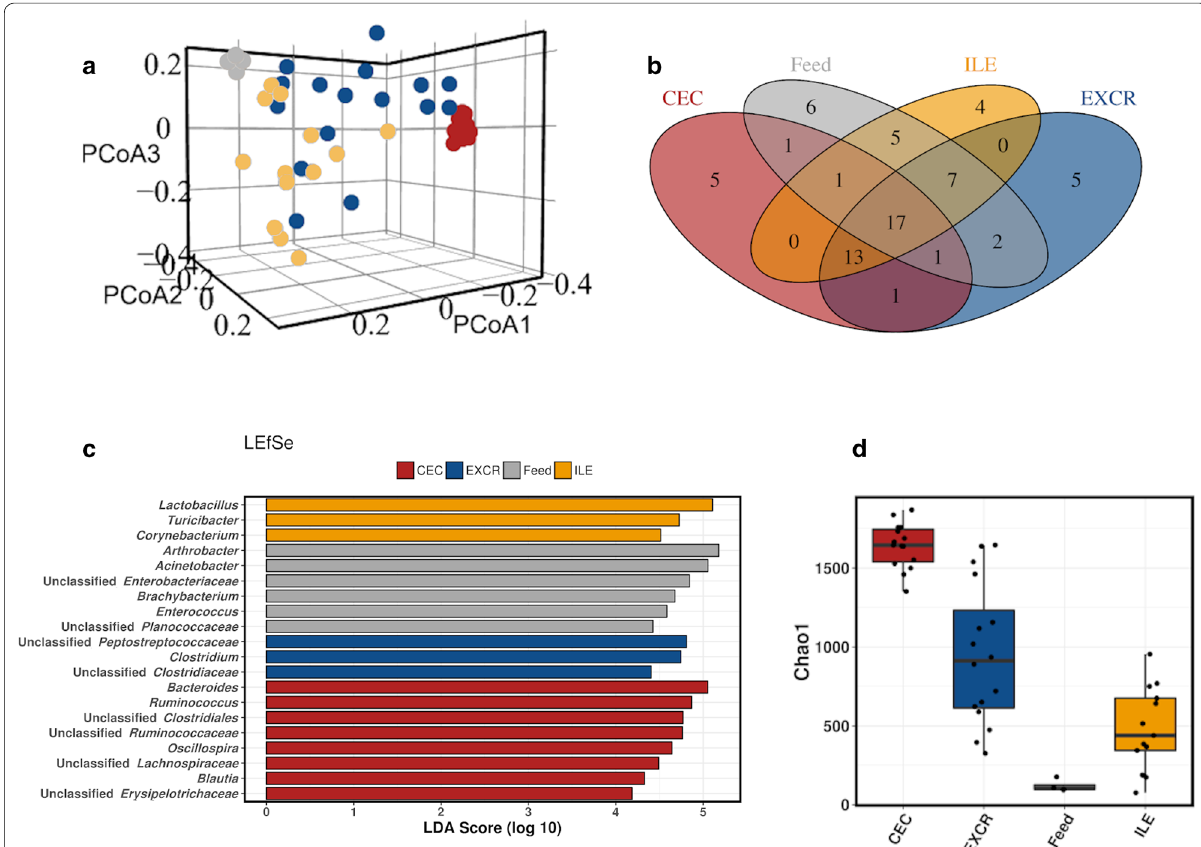
Fig. 1 Comparison of feed microbiota with ileum, cecum and excreta microbiota. The Fig. presents 3D PCoA plot based on unweighted UniFrac distance ( a ); core microbiota at a genus level ( b ); LEfSe analysis of the top 50 genera ( c ) and Chao 1 microbial richness estimator ( d ). In all plots feed samples are represented in grey, cecum in red, ileum yellow and excreta in